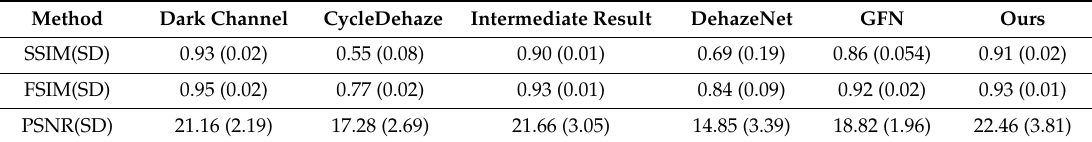
Table 5. The SSIM and PSNR score on the four